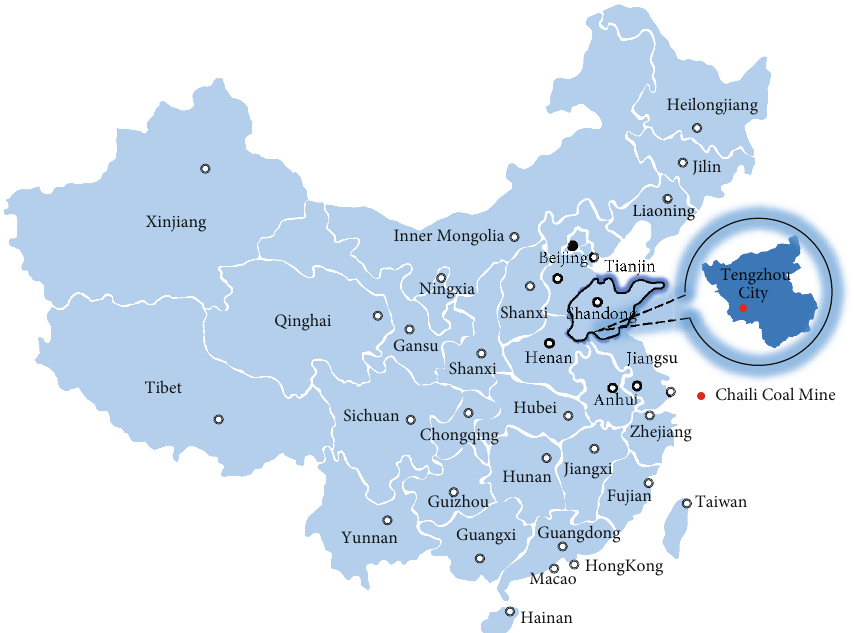
Figure 1: The position of Chaili Coal